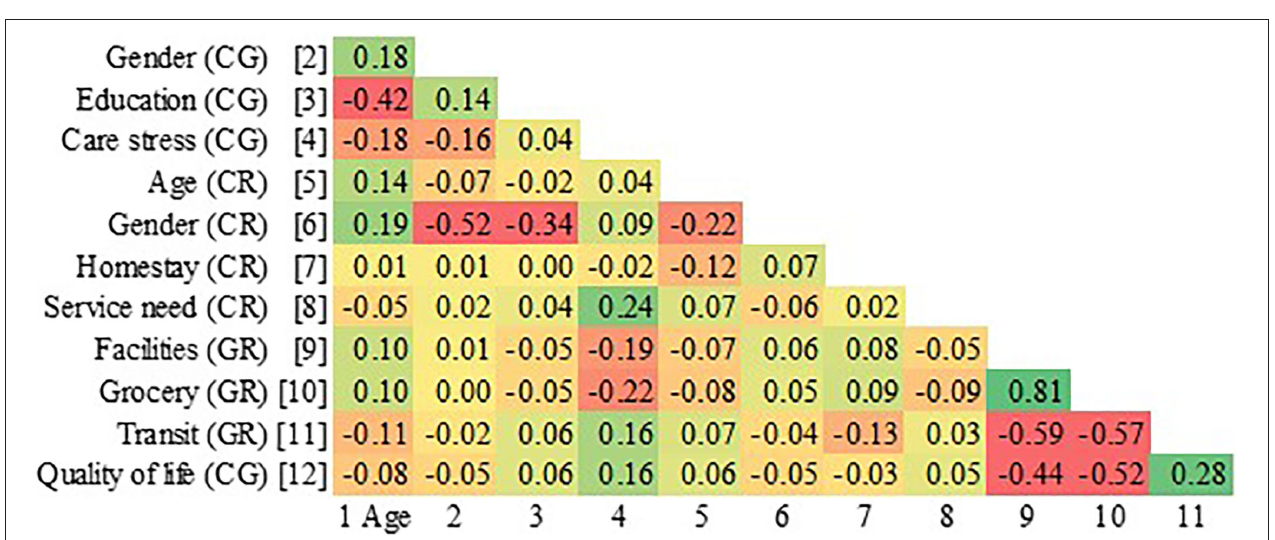
FIGURE 2 | Correlational matrix. CG, caregiver; CR, care recipient/frail older adults; GR, both frail older adults and caregivers.